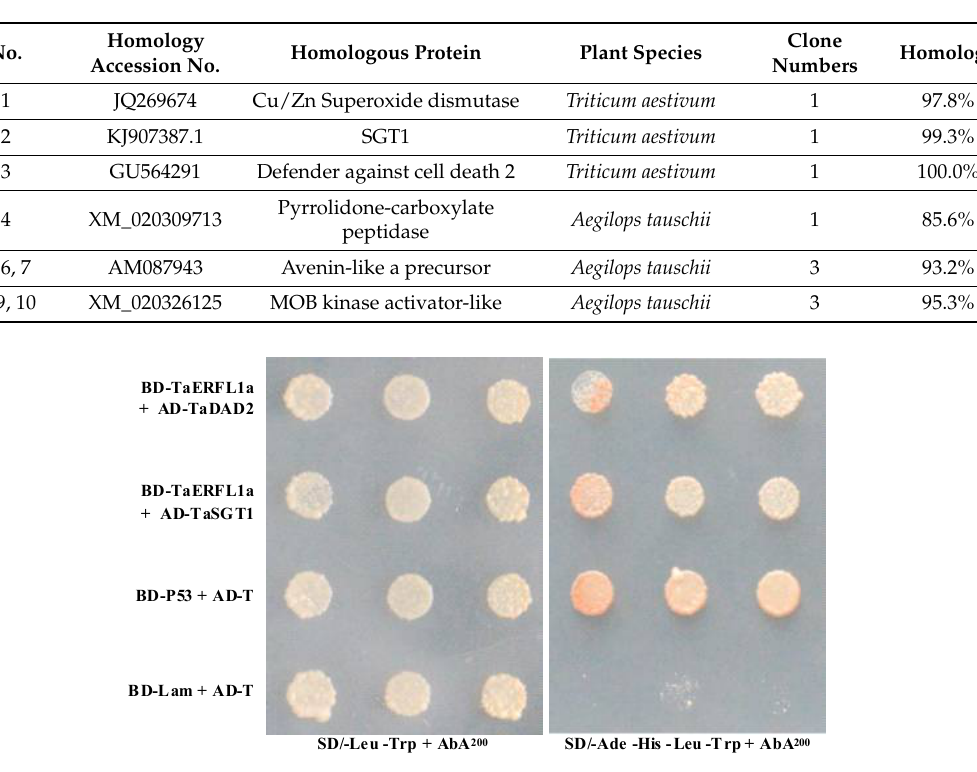
Figure 6. Interactions of TaERFL1a and TaSGT1, or TaERFL1a and TaDAD2 in a Y2H system. Transformed TaERFL1a and TaSGT1, or TaERFL1a and TaDAD2 grow on SD/-Leu/-Trp and SD/-Ade-His-Leu-Trp + AbA 200 selected media. BD-P53 + AD-T (pGBKT7-P53 + pGADT7-RecT) and BD-Lam + AD-T (pGBKT7-Lam + pGADT7-RecT) represent the positive and negative controls, respectively.